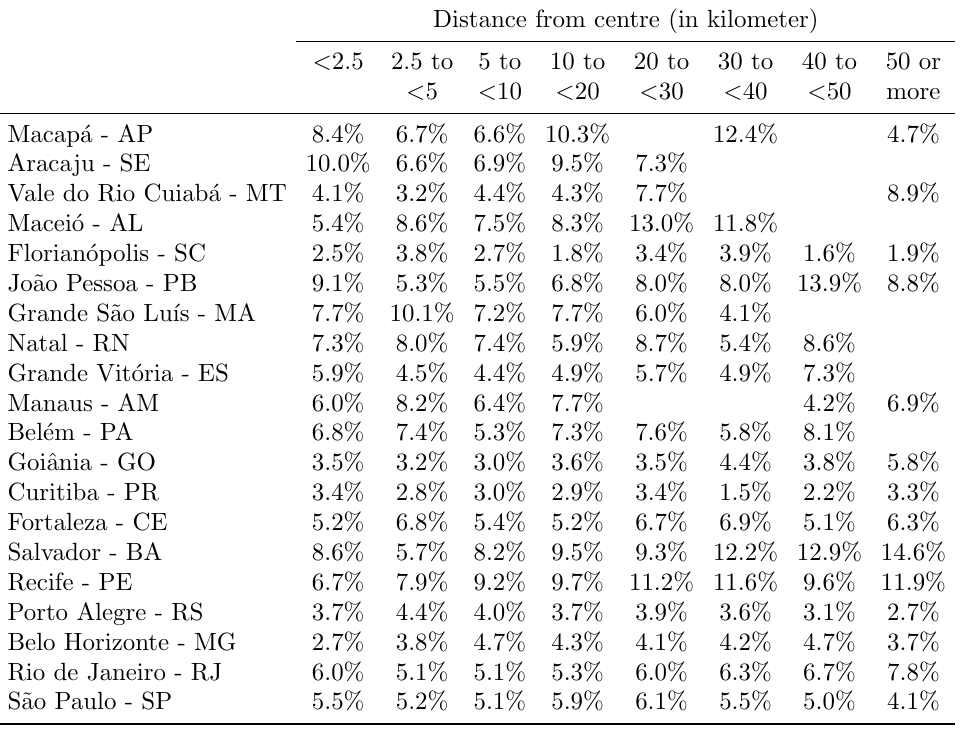
Table A.3: Average unemployment rate in each weighting area by the distance to the main business centre,